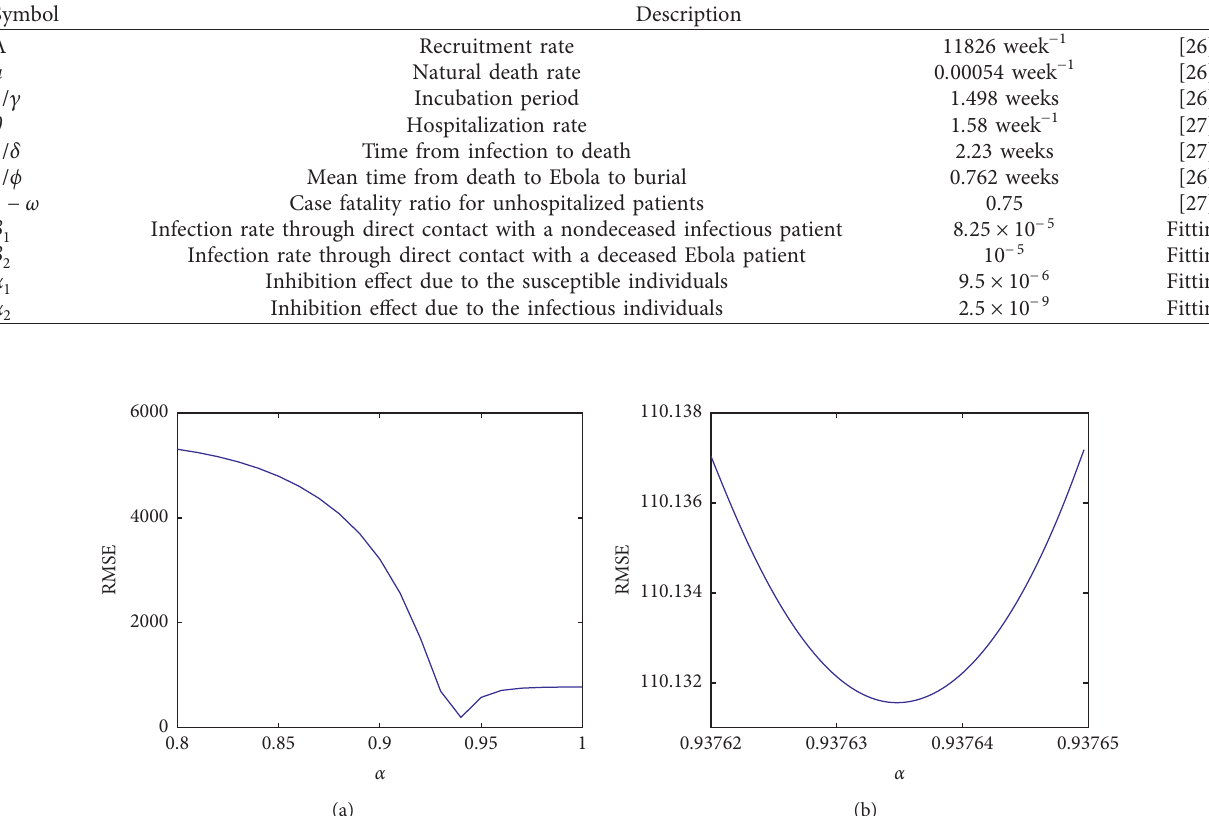
Table 2: Description of model parameters of system (8), indicating baseline, ranges, and references.